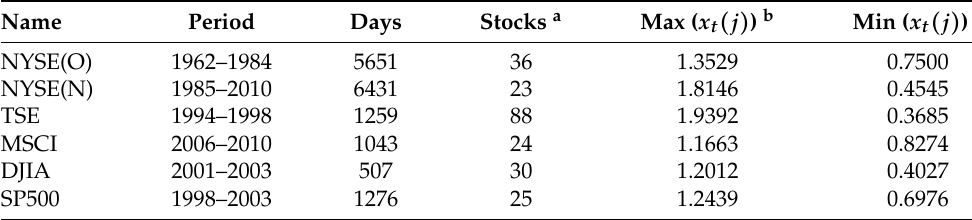
Table A1. Summary of traditional datasets.